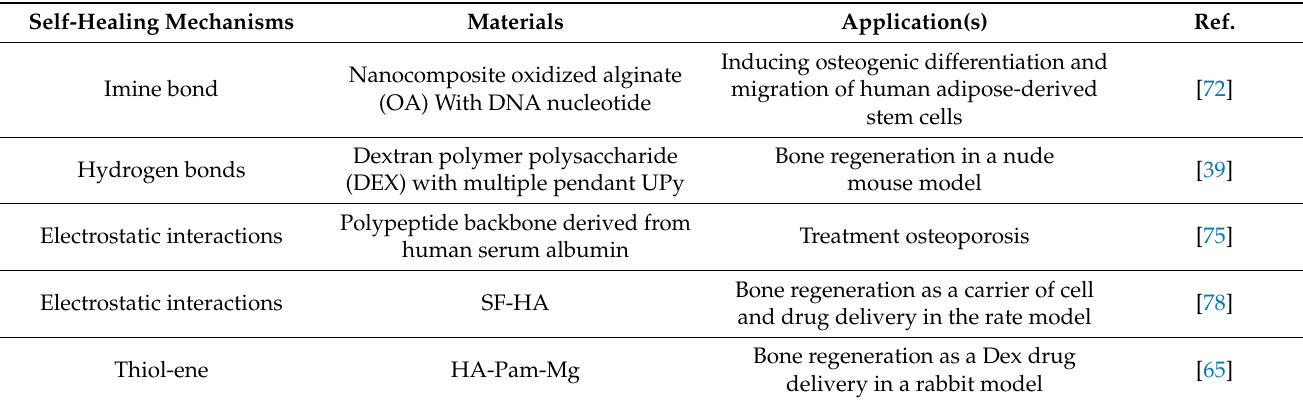
Table 3. Examples of self-healing hydrogels for bone